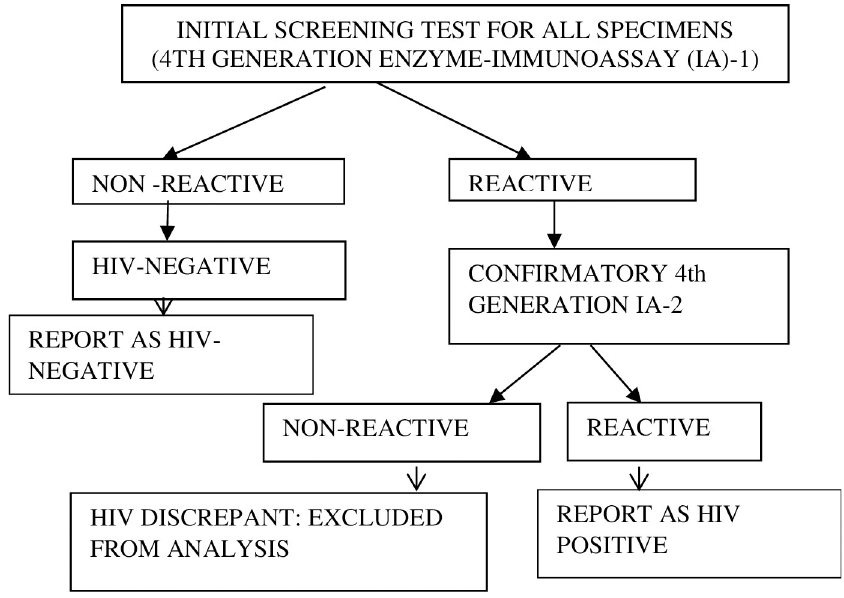
Fig 1. The laboratory HIV testing algorithm for the 2017 Antenatal HIV Sentinel Survey, South Africa.